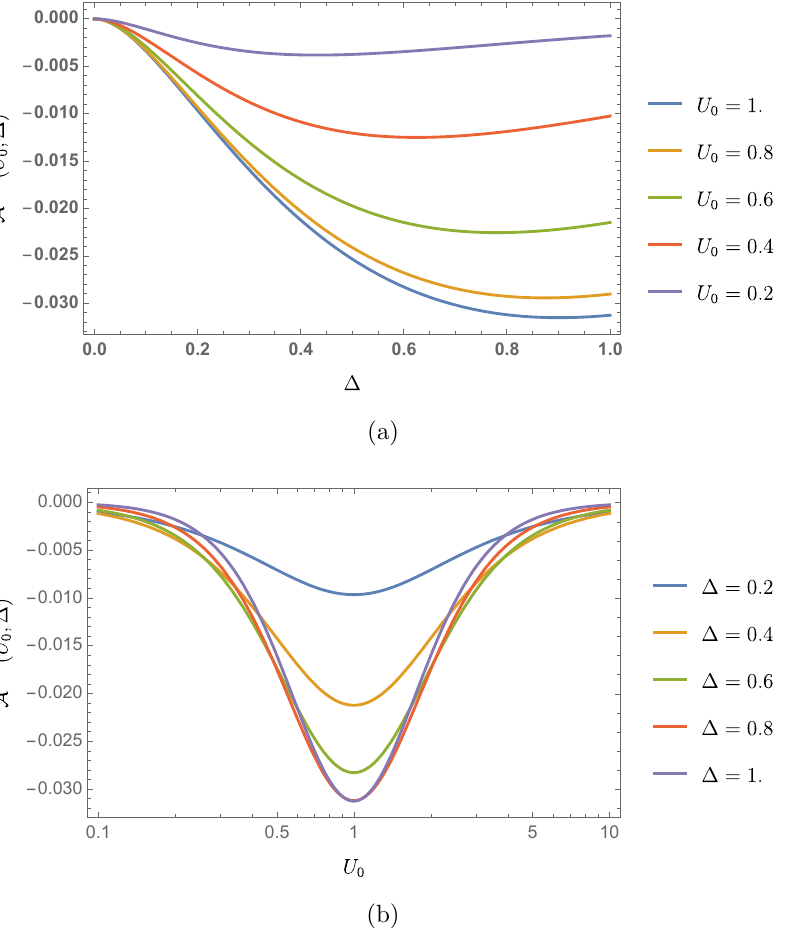
Figure 3. Averaged Null Energy for the case of instantaneous sources. In (a) we plot the ANE as a function of (cid:1) for di(cid:11)erent U 0 . The largest amount of ANE (in absolute value) is given by the curve with U 0 = 1. This corresponds to t L = t R = 0. Note that for this choice of times, the wormhole is shortest; therefore, it is not surprising that the e(cid:11)ect of the non-local coupling is the largest. In (b), we plot the ANE as a function of U 0 for di(cid:11)erent (cid:1). The scale on the U 0 axis is logarithmic which makes evident that each curve has a minimum at U 0 = 1 and is symmetric under U 0 ! U (cid:0) 1